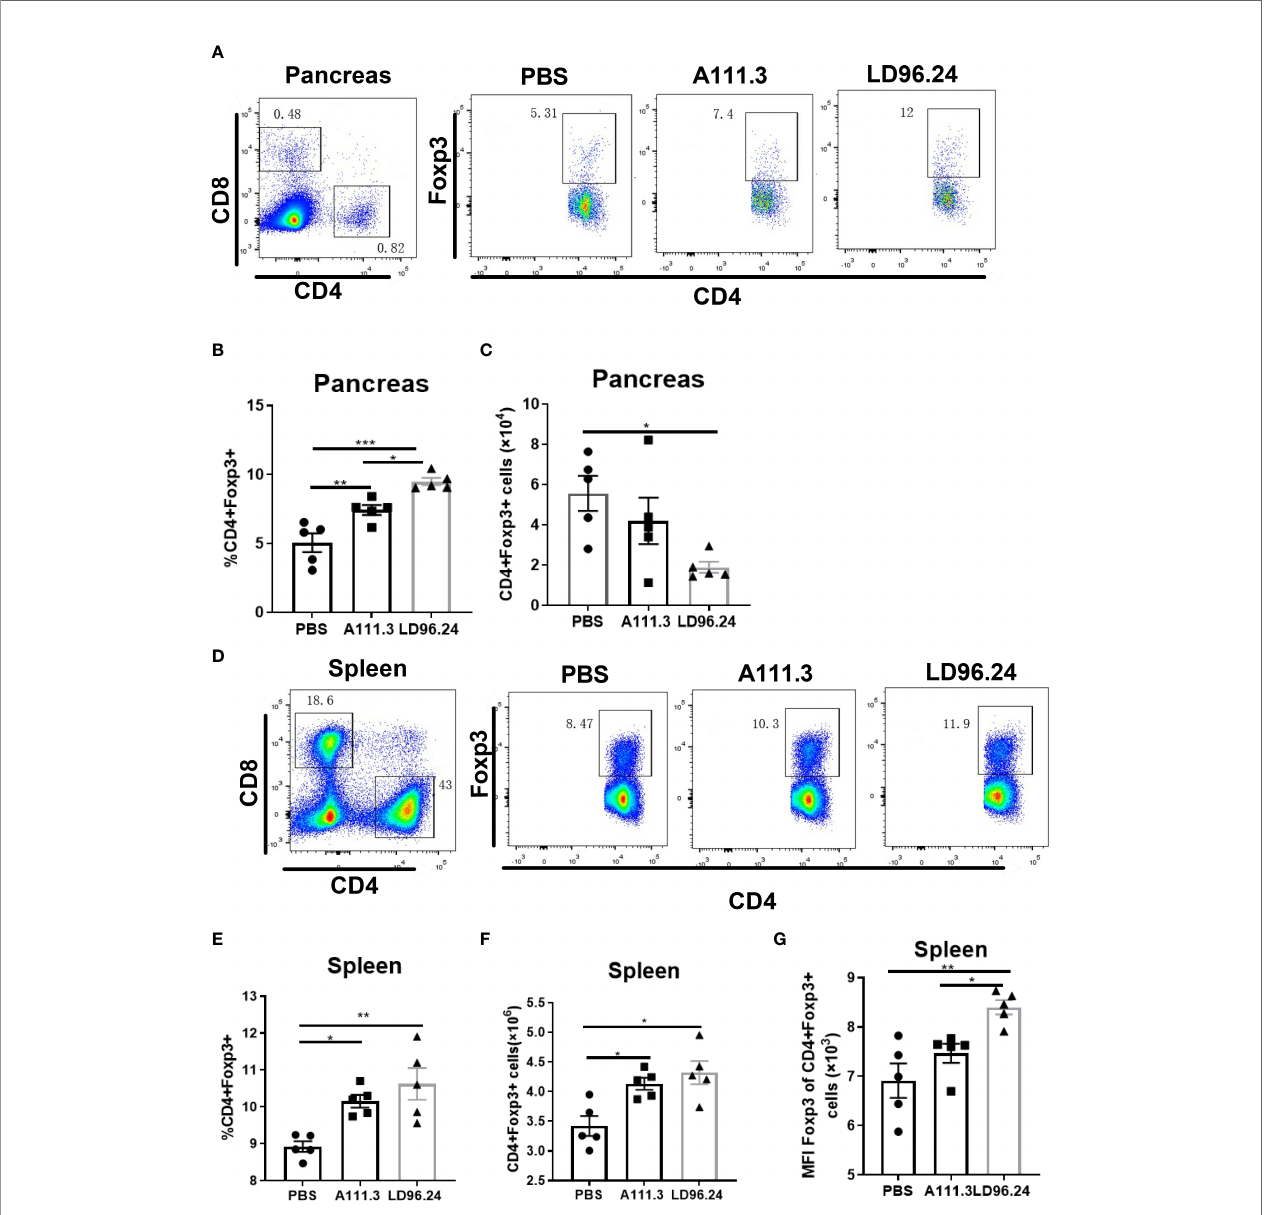
FIGURE 6 | The impact of LD96.24 on CD4 + Treg in pancreas and spleen. Three groups (5 NOD mice/group) were treated weekly from age 4 weeks with PBS, 0.5 mg A111.3 or LD96.24, and pancreatic cells were isolated at age 10 weeks. Cell surface antibodies were stained with BV605-B220, APC eFluor 780-CD8, Alexa Fluor 700-CD4 + , and PerCP-Cy5.5-CD44. Then, intracellular staining with APC-Foxp3 was done using the eBioscience Foxp3/Transcription Factor Staining Buffer Set (Thermo Fisher Scienti fi c) according to the manufacturer ’ s instructions. Stained single-cell suspensions were analyzed using a Fortessa fl ow cytometer running FACSDiva (BD Biosciences). (A – C) The percentages and cell number of CD4 + Foxp3+Tregs in the pancreas. (D-F) The percentages and cell number of CD4 + Foxp3 +Tregs in the spleen. (G) The mean fl uorescence intensity (MFI) of CD4 + Foxp3+Tregs in the spleen. Data are the means ± SEM of each group. Statistical analysis was performed using one-way ANOVA with Tukey ’ s multiple comparison test. *P < 0.05, ** P < 0.001, *** P <